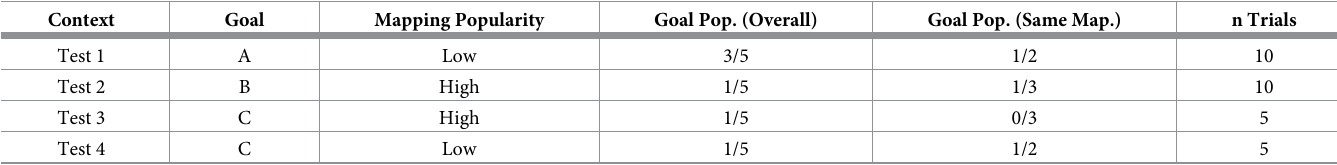
Table 3. Test contexts for experiment 3. Goal popularity, both overall and for contexts with shared mappings, is denoted as the fraction of contexts in training with the same goal.